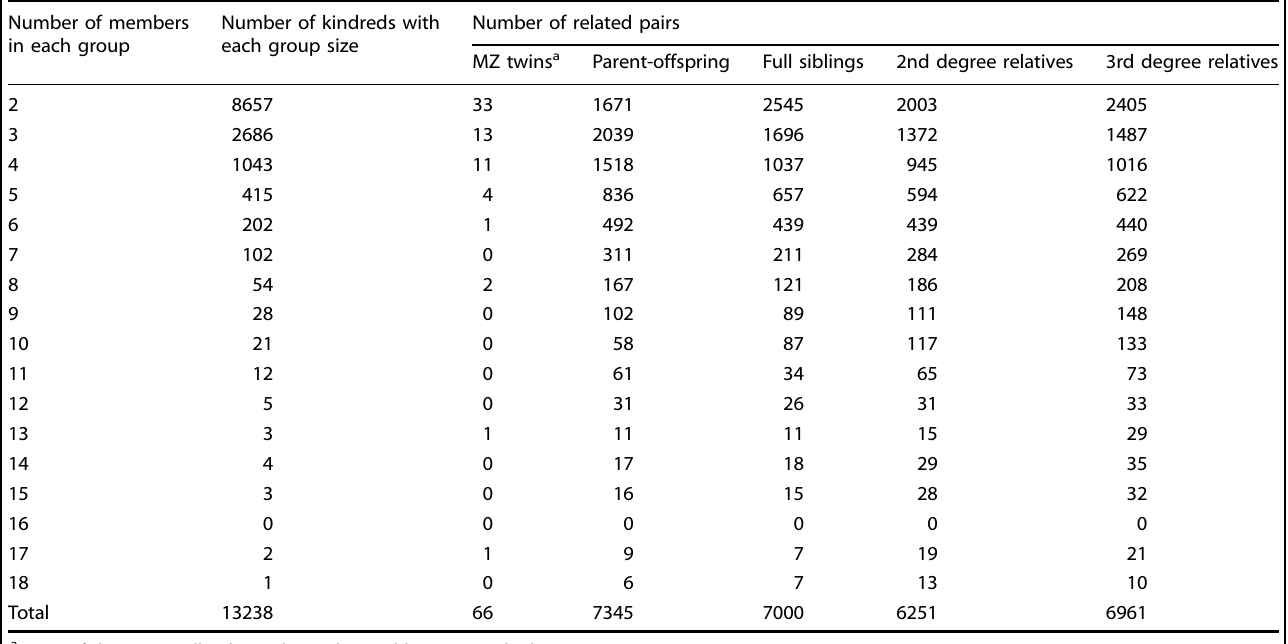
Table 1. Kinship distribution of 34,823 related individuals in the TWB cohort. Number of members Number of kindreds with in each group each group